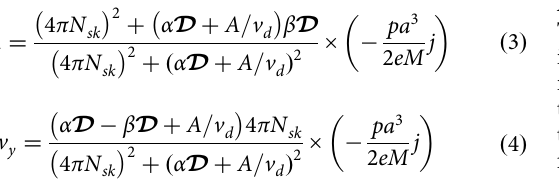
Fig. 1 A single skyrmion in a Co 9 Zn 9 Mn 2 -based microdevice at room temperature (RT). a Schematic of the crystal structure of Co 9 Zn 9 Mn 2 (space group: P 4 P 4 1 32 or 3 32). b The cross-section drawing of the microdevice consisting of a (001) Co 9 Zn 9 Mn 2 thin plate (see details in Supplementary Fig. 1). c Magnetic induction maps of a metastable skyrmion generated at RT and a magnetic fi eld of − 80 mT applied along the – z -direction. The inset in ( c ) shows the over-focus L-TEM image of the skyrmion. The color wheel encodes the direction of in-plane magnetic components, and dark contrast encodes the out- of-plane components. d Schematic of skyrmion motion with the translational displacement ( 4 x ) and transverse displacement ( 4 y ) induced by pulsed electric current ( j ) fl owing from left to single skyrmion, as marked within the L-TEM images of Fig. 2d, i, demonstrate that the straight skyrmion motions is reversed by reversing the current direction (Fig. 2e, j). The abovementioned L-TEM observations indicate an ef fi cient control of single- skyrmion motion by nanosecond current pulses. Reversal of skyrmion Hall motion . By fl ipping the direction of the magnetic fi eld applied normally to the thin plate, the topo- logical number is changed from N sk = + 1 (Fig. 3a) to N sk = − 1 (Fig. 3f) as de fi ned by Eq. (1). When the electric current with a density j fl ows along the x -axis, the resultant skyrmion velocities v v 6 , x and y can be written as